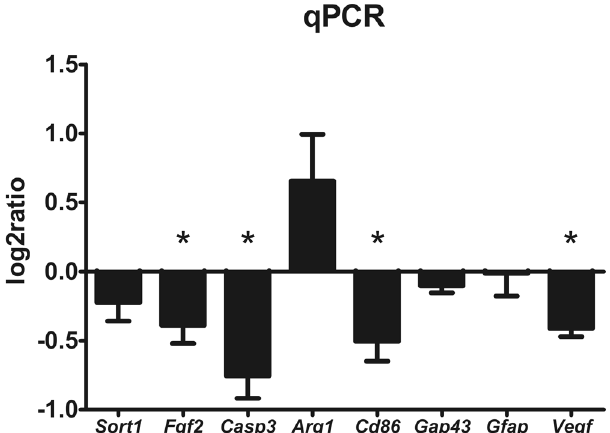
Figure 10. mRNA expression profiling in the lesion center 9 weeks after SCI. The graph shows the log2-fold changes in gene expression in the laser-treated group compared to control animals. Expression of Fgf2 , Casp3 , Cd86 and Vegf was significantly downregulated in the spinal cords of laser-treated animals. n = 4 per group. The values are expressed as mean ± SEM. * p <